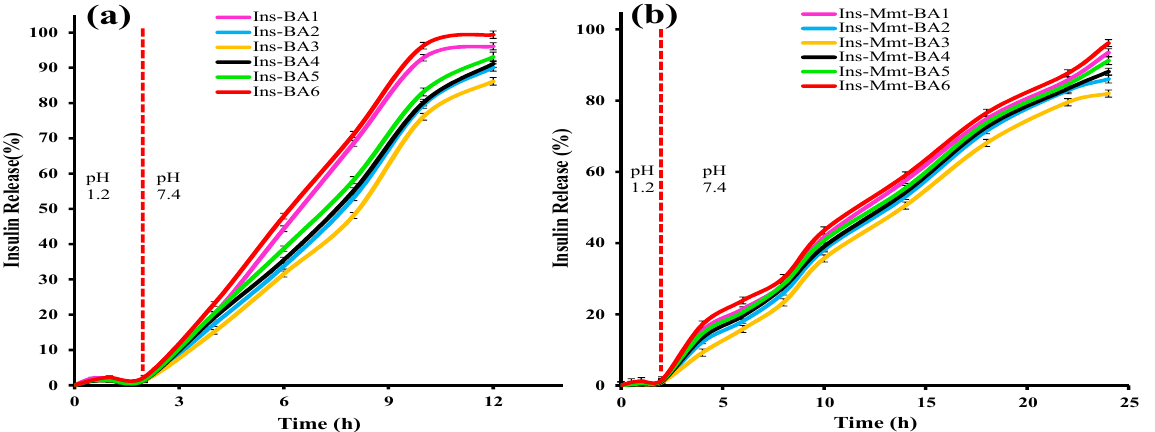
Figure 9. In vitro release profiles of all Ins-BA hydrogel ( a ) and Ins-Mmt-BA hydrogel NC ( b ) formulations with different monomer and crosslinker contents.